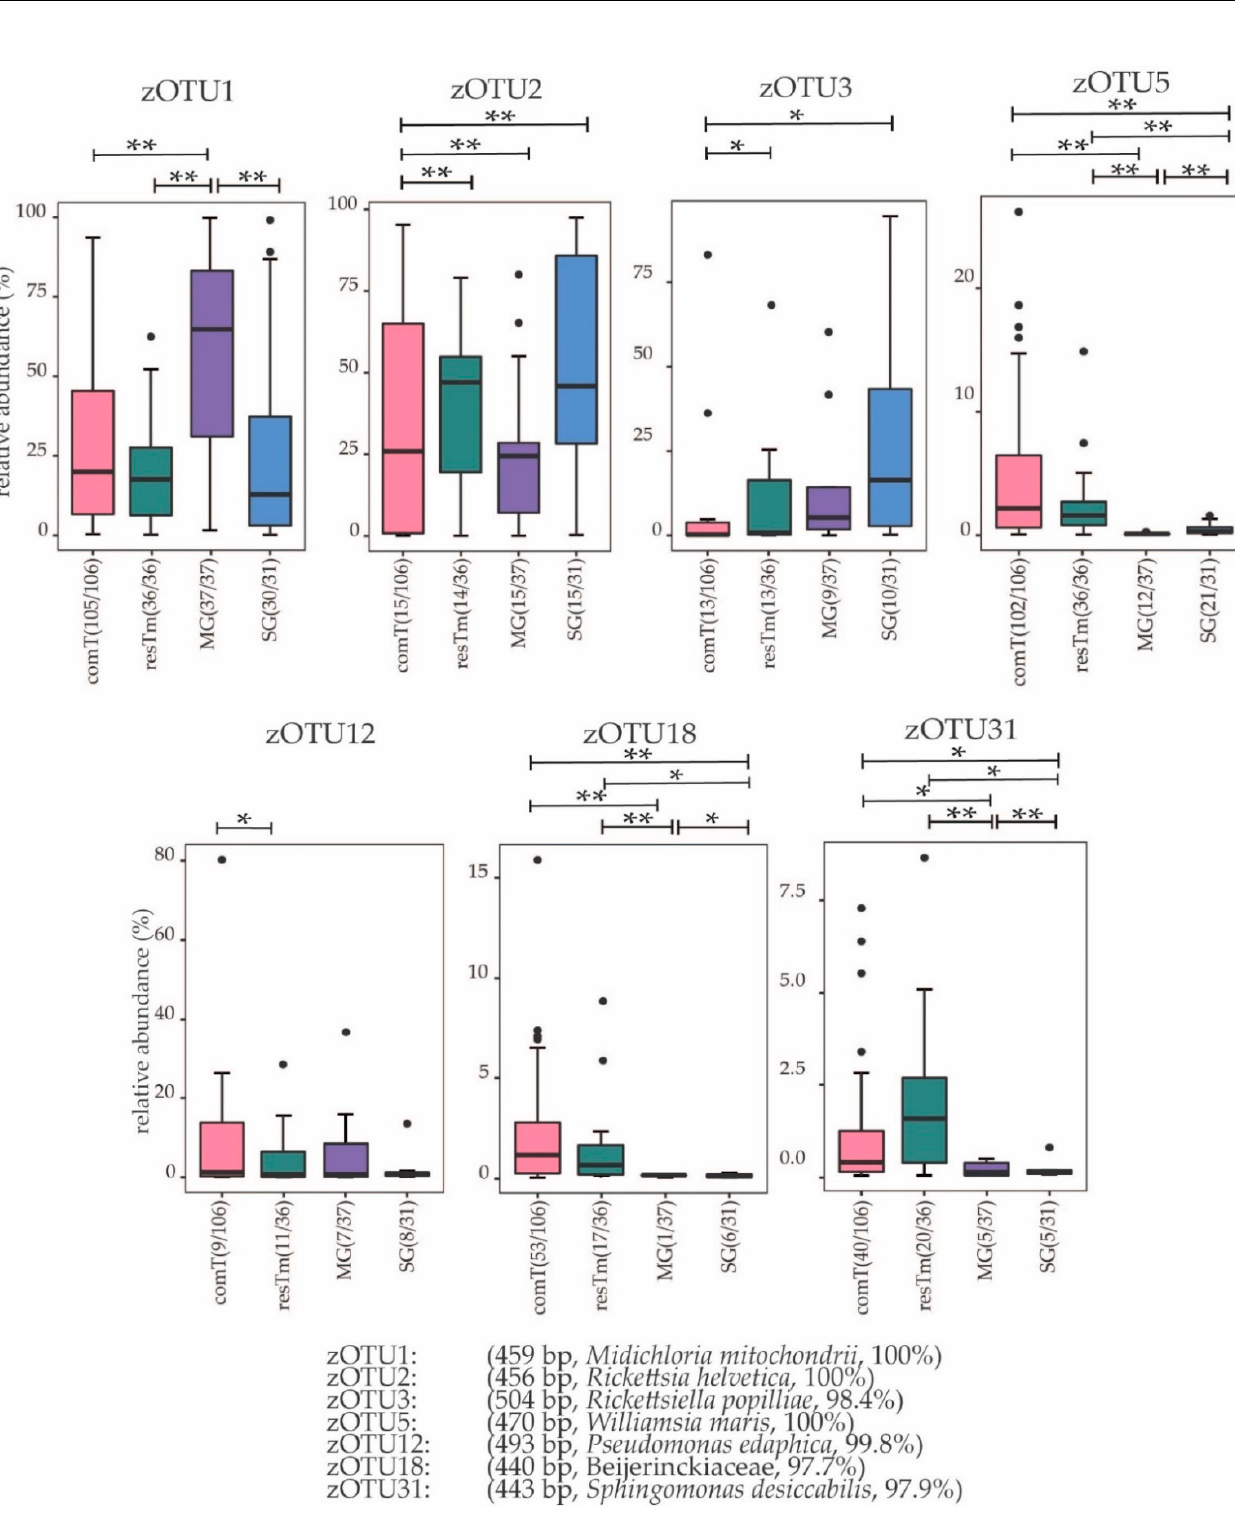
Figure 5 . Box-blot representation of molecular strains relative abundance according to sample types. Box-plots visualize the median (thick bar), upper and lower quartile (within box), and standard deviation (whiskers). Outliers appear as dots. Brackets above the individual box-plots show significance for pairwise comparison. zOTUs were identified by EzBioCloud [40]; the sequence length, the closest relative taxon, and the sequence similarity score of zOTUs are shown in the order of appearance. zOTU: zero-radius operational taxonomic unit. comT, complete Ixodes ricinus tick; resTm, residual tick material; MG, midgut; SG, salivary gland. p value summary: * p ≤ 0.05, ** p ≤ 0.01.